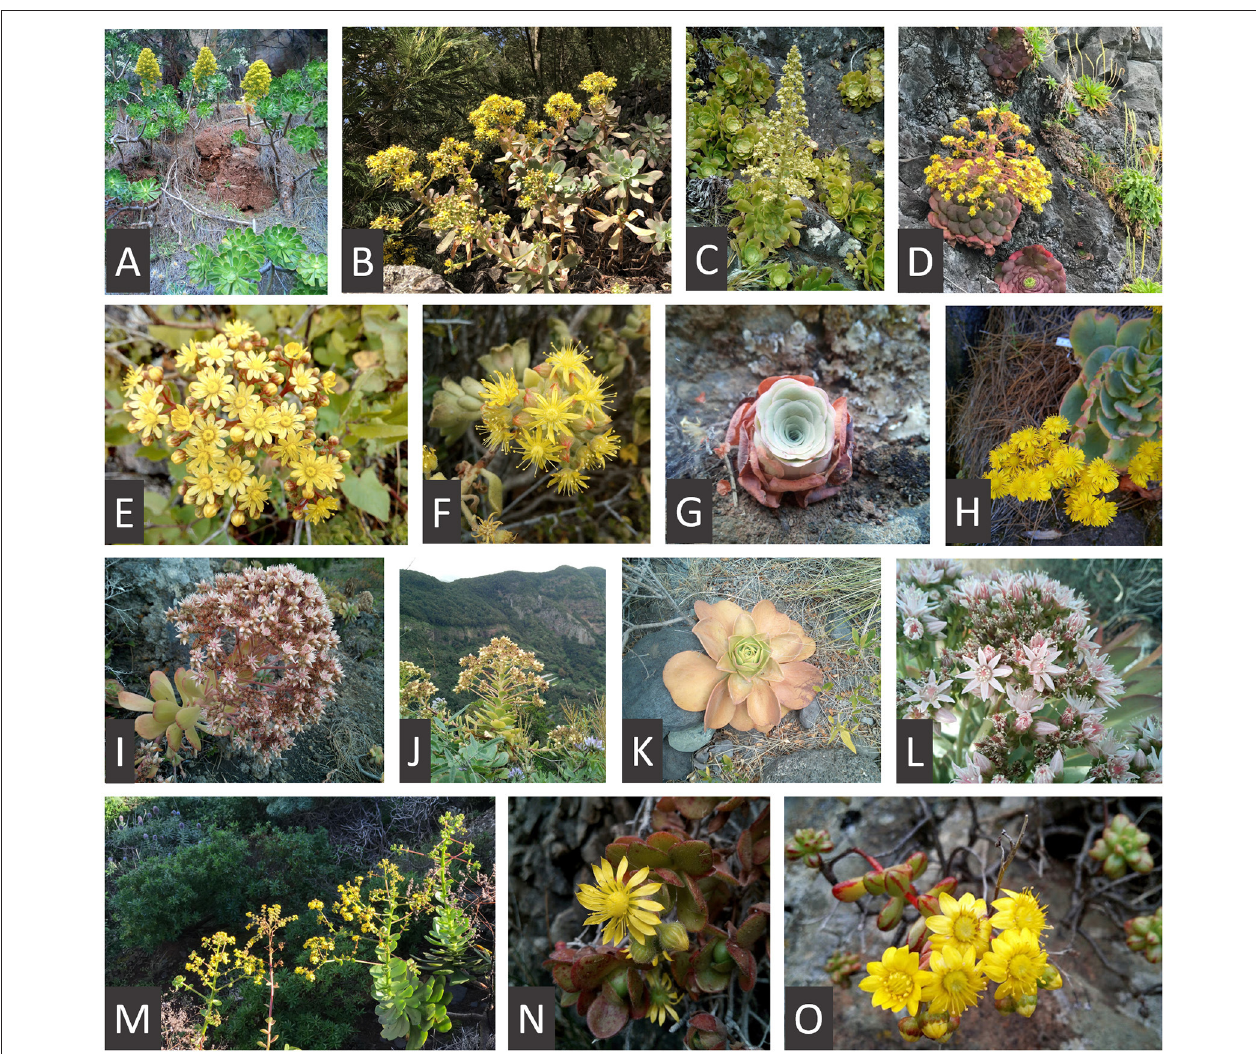
FIGURE 1 | Morphological diversity in Aeonium s.l. sections. (A,B) : Section Aeonium ( A. arboreum subsp. holochrysum , and A. gorgoneum ). (C,D) : Section Canariensia ( A. canariense subsp. canariense ; and A. glandulosum ). (E) : Section Chrysocome ( A. spathulatum ). (F) : Section Goochia ( A. lindleyi subsp. lindleyi ). (G,H) : Section Greenovia ( A. aureum ; and A. diplocyclum ). (I–L) : Section Leuconium ( A. davidbramwelii ; A. gomerense ; A. urbicum ; and A. nobile ). (M–O) : Section Petrothamnium ( A. glutinosum ; A. saundersii ; and A. sedifolium ). All species pictured have been sampled in the current study and by some of the authors (MB; GR;